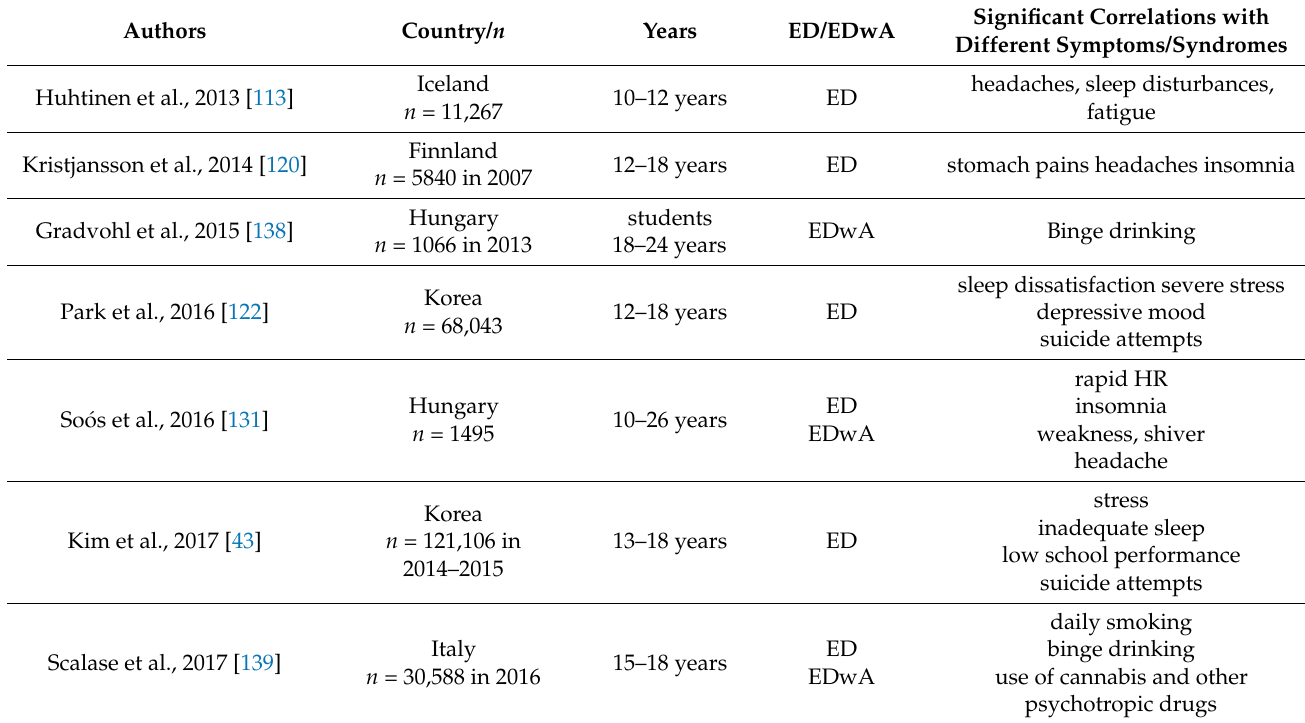
Significant Correlations